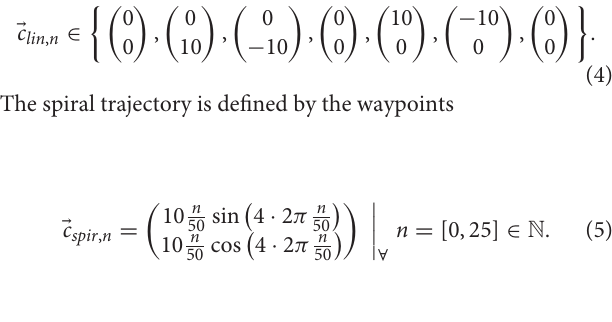
estimated movement and reference movement allows